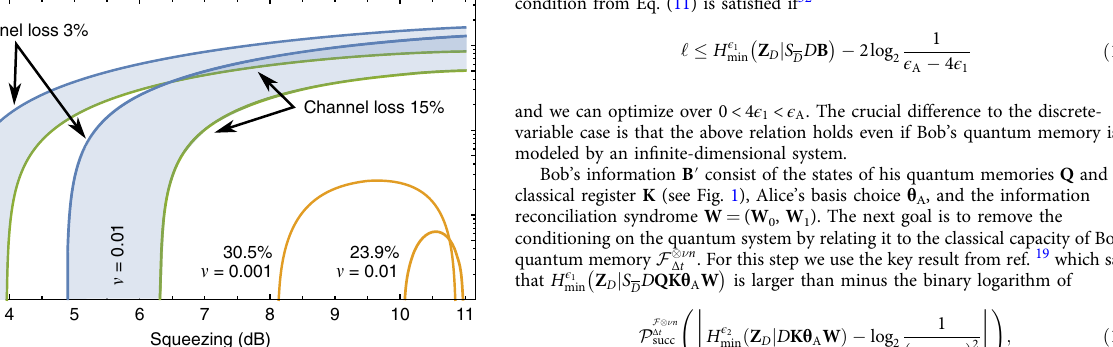
Fig. 5 Simulation of oblivious transfer rate. Simulation of oblivious transfer rate under Gaussian assumption versus the amount of squeezing used to prepare the EPR state for two different storage rates ν = 0.01 and ν = 0.001. The shaded areas correspond to a channel loss between 3 and 15% which is the experimentally investigated region. The orange traces are calculated for a channel loss close to the maximum possible value for the respective storage rate. The anti-squeezing of the employed squeezed state was calculated using parameters characterizing the experimental squeezed light sources and homodyne detectors: 98.2% escape ef fi ciency, 79.8 mm optical round-trip length, 8 MHz sideband frequency, 91.4% total optical ef fi ciency. Other parameters: information reconciliation ef fi ciency 92.5%, n = 2 × 10 5 samples, ϵ = 10 − 7 , α = 51.2, δ = 0.1, N = 100, cut max A transmittance of quantum memories